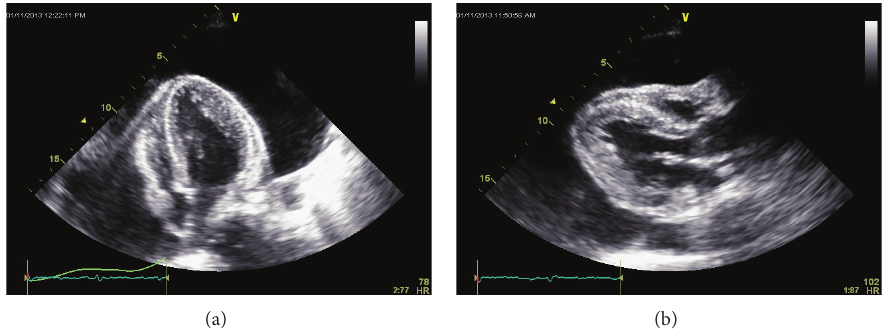
Figure 3: Echocardiogram. (a) Apical four-chamber view showing “swinging heart” and large pericardial effusion, (b) parasternal long axis view showing right ventricular diastolic collapse.